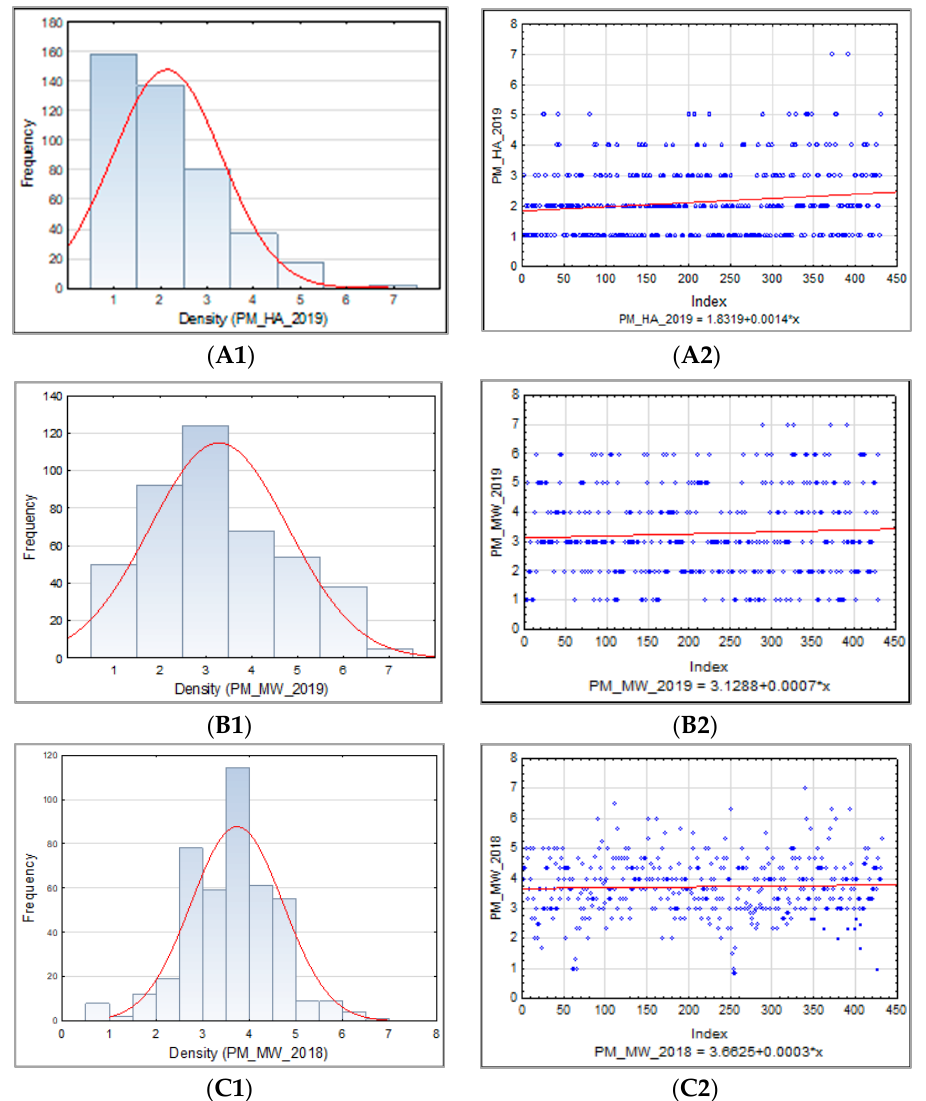
Figure 3. Frequency distribution of the barley accessions for powdery mildew (PM) resistance scores at heading (HA) and milky-wax (MW) stages in 2019 and MW stage in 2018. Figures ( A1 ), ( B1 ), and ( C1 ) present the normal Gauss frequency distribution. Figures ( A2 ), ( B2 ), and ( C2 ) present regression analysis model to estimate relationship between PM resistance scores and frequency index. Disease severity scored on the 1–9 scale (1 = immune